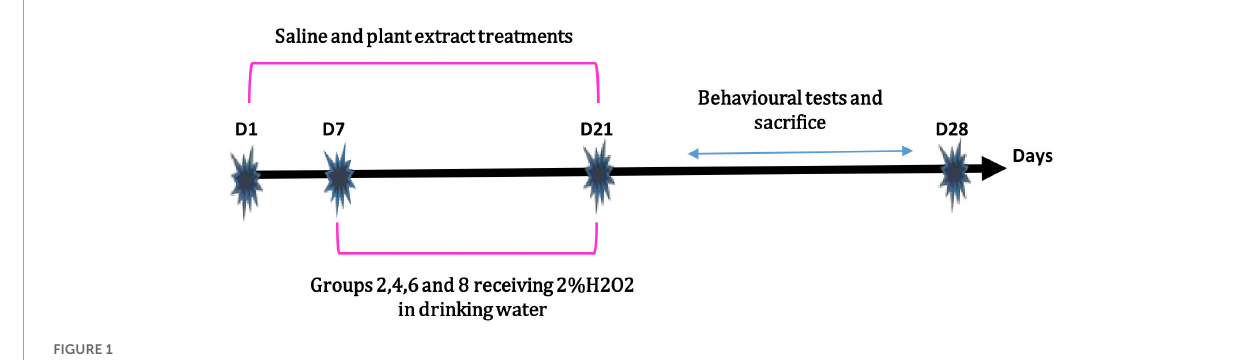
FIGURE1 Experimental design of the in vivo study.